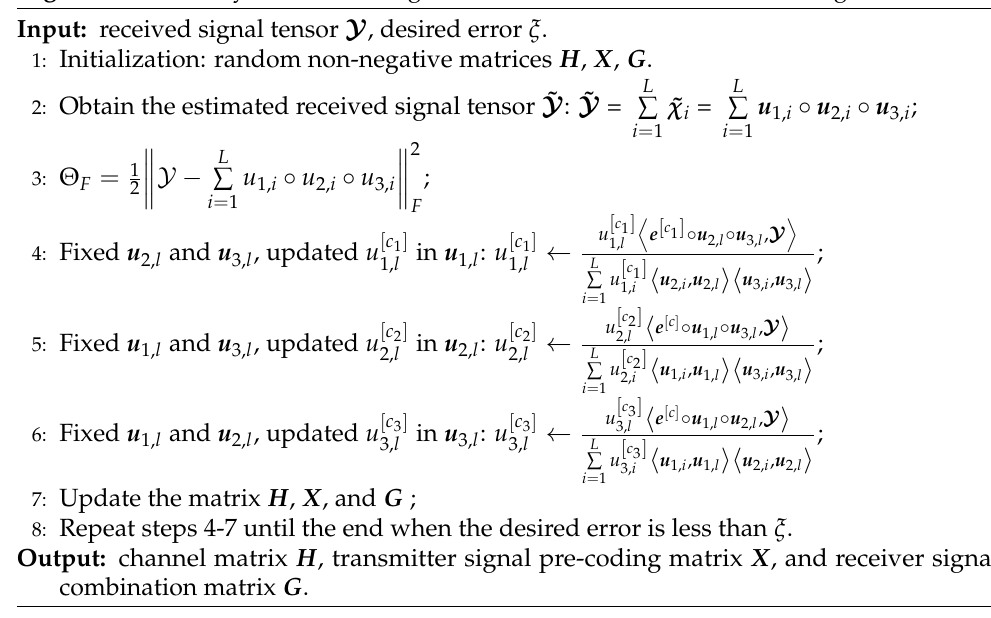
Algorithm 1 Fast-layered alternating iterative tensor channel estimation